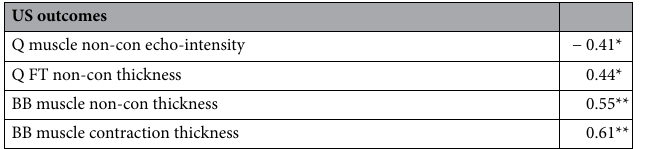
Table 3. Significant correlations (r) between the QLQ-BR 23 questionnaire (PRO) and US outcomes. BB, biceps brachii and brachialis; QLQ-BR 23, Quality of Life Questionnaire Breast Cancer; Q, quadriceps; EI, echointensity; PRO: Patient-Reported Outcomes; non-con, non-contraction; US, Ultrasound imaging. *p < 0.05; **p < 0.01.